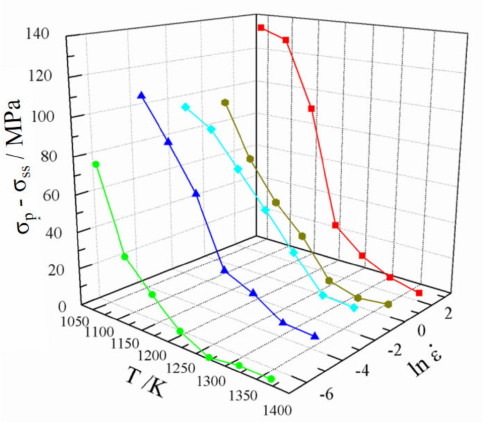
Figure 3. The relationship between strain rate, temperature, and flow